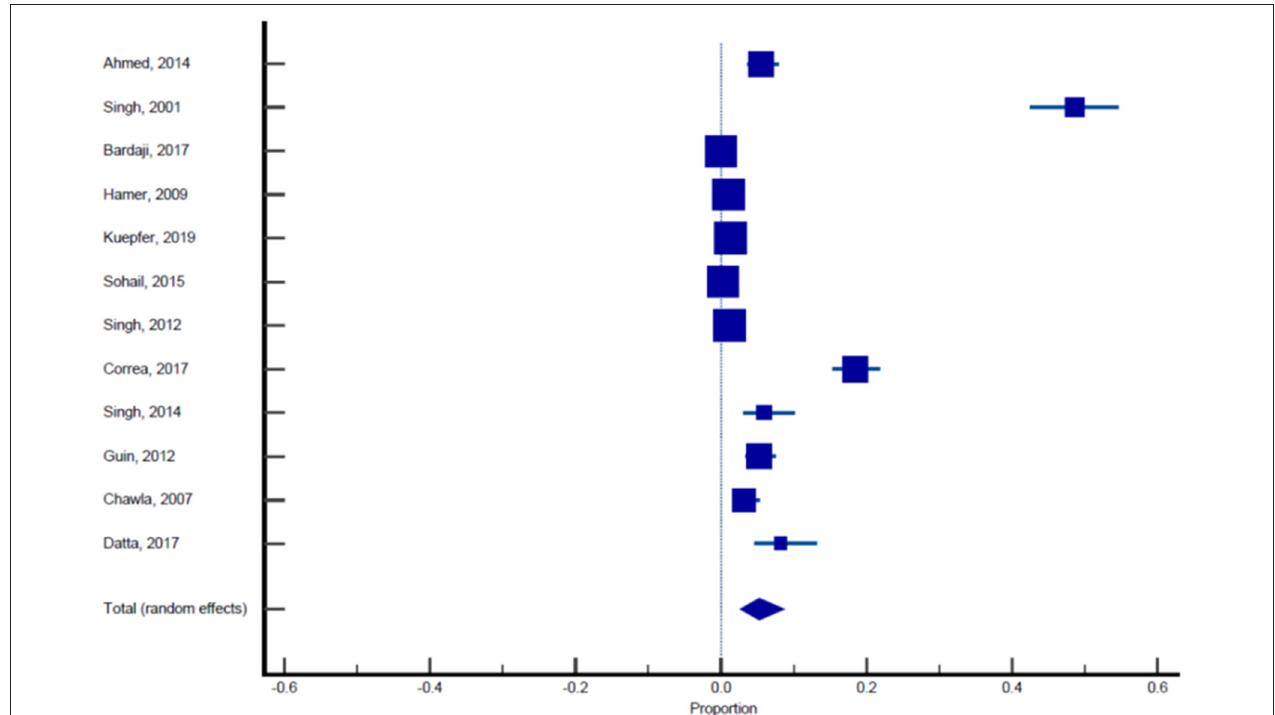
FIGURE 7 | Pooled estimates of the prevalence of Plasmodium falciparum infection among pregnant women.